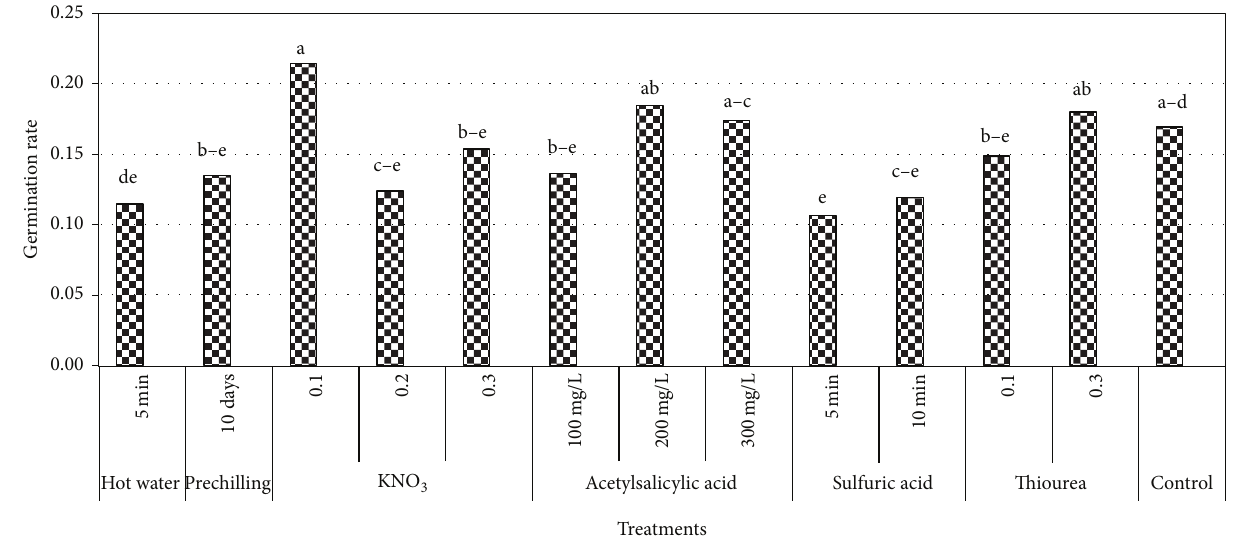
Figure 2: Comparison effects of various treatments on germination rate of C. persica